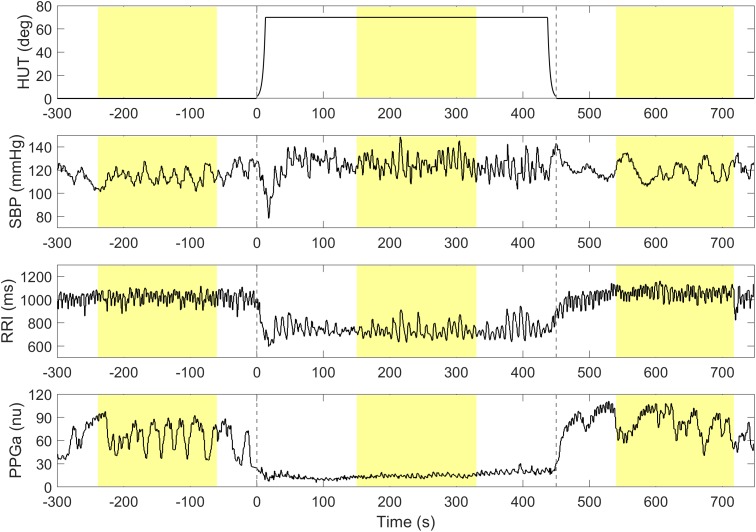
A representative data segment pre-, during and post-HUT. Vertical dashed lines indicate the onset and the end of HUT. The mean values of SBP, RRI and PPGa during pre-, during and post-HUT are calculated from the shaded areas.